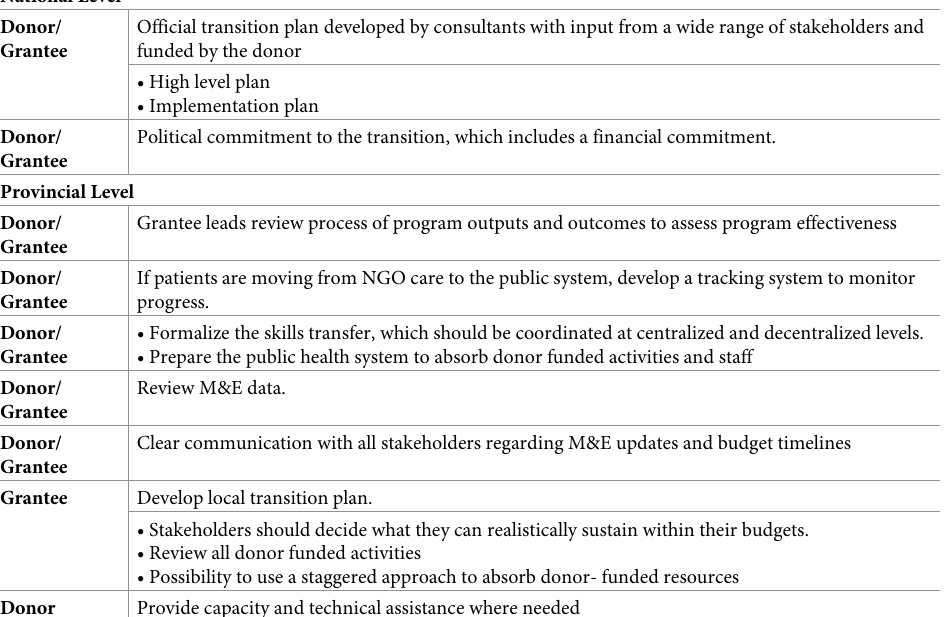
Table 7. Transition period (final 2–5 years before program